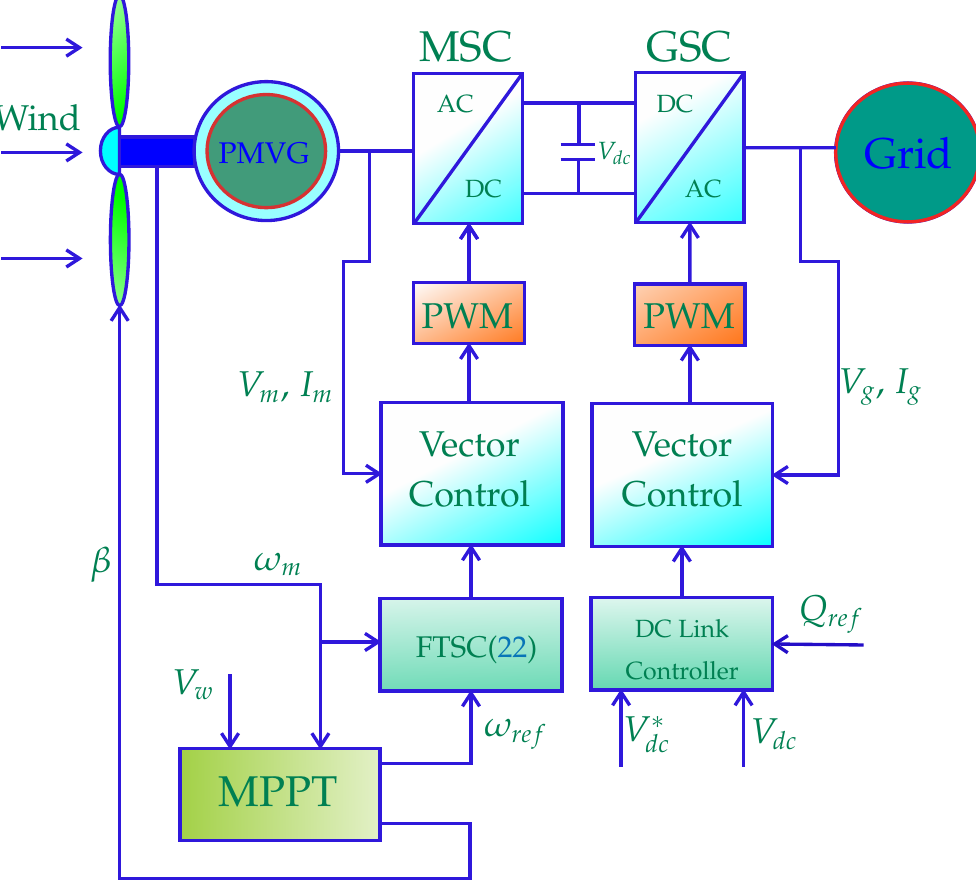
Figure 3. Block diagram of the proposed control scheme for PMVG-based